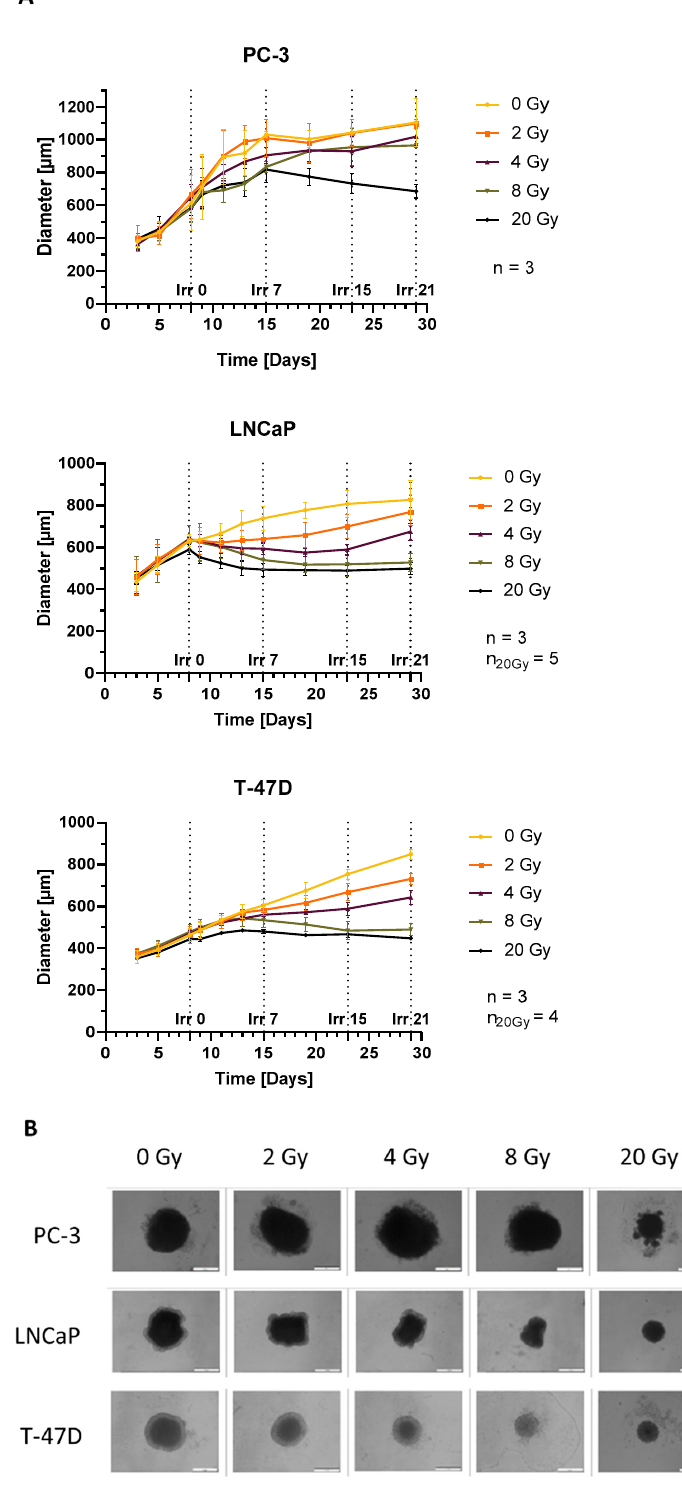
Figure 3. Growth observation of spheroids after single irradiation with 0, 2, 4, 8 or 20 Gy on day 8 (Irr 0); ( A ) Diameter of spheroids; average over three diameter measurements per spheroid and time point plotted as mean ± standard deviation from three to five independent experiments ( n = 3–5); Irr 0, 7, 15 and 21 indicate the time after irradiation in days ( B ) Growth analysis of spheroids on day 29 (Irr 21); white scale indicates 500 µm.